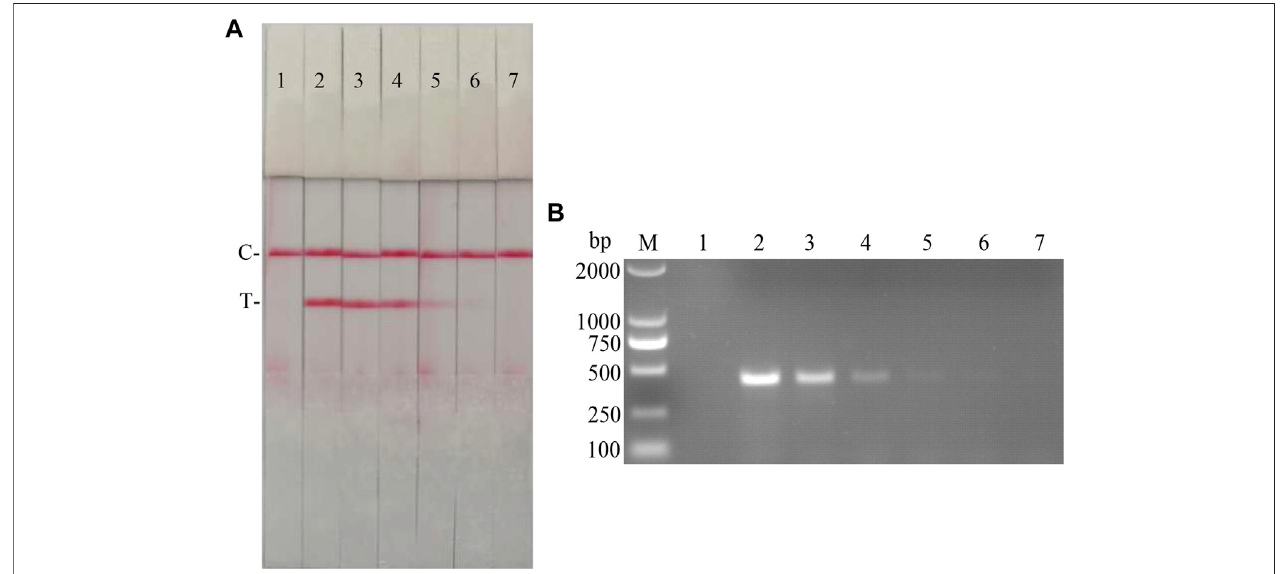
FIGURE11| ViraltitersensitivityanalysisoftheCSFVRAA-stripassay. (A) Thesensitivity testresultofCSFVcDNAbyCSFVRAA-stripinorder. (B) wasthatbythe conventional PCR assay. C is a control line. T is a test line. M is a 2,000 bp DNA marker. The templates used in lane 1 – 7 successively are: negative control, 10 4.7 , 10 3.7 ,